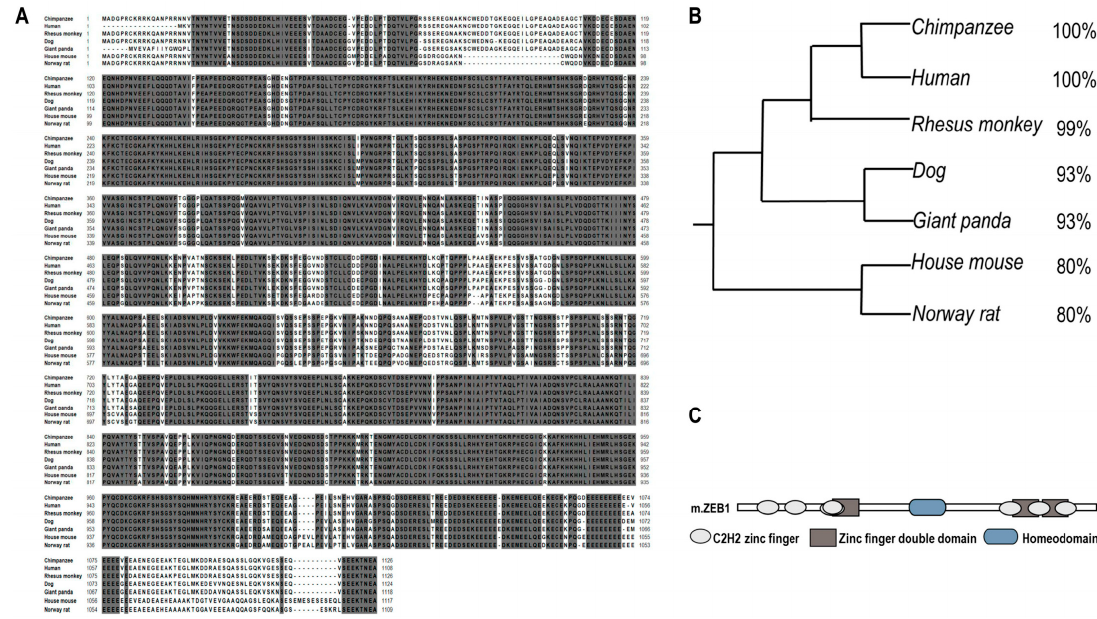
Figure 1. Bioinformatic analysis of Zeb1 protein. ( A ) Several tracks of entire amino acid sequences of Zeb1 across different mammal species. NCBI was used to get the sequences that were 1117aa in length and were highly conserved shown in gray shadow representing 100% matched sequences across different species; ( B ) Rooted phylogenetic tree (UPGMA) displayed Zeb1 is highly homologous among different mammalian. The identity is shown on the right; ( C ) Zeb1 protein structure contains seven C2H2 zinc finger domains, three zinc finger double domains and one homeodomain.